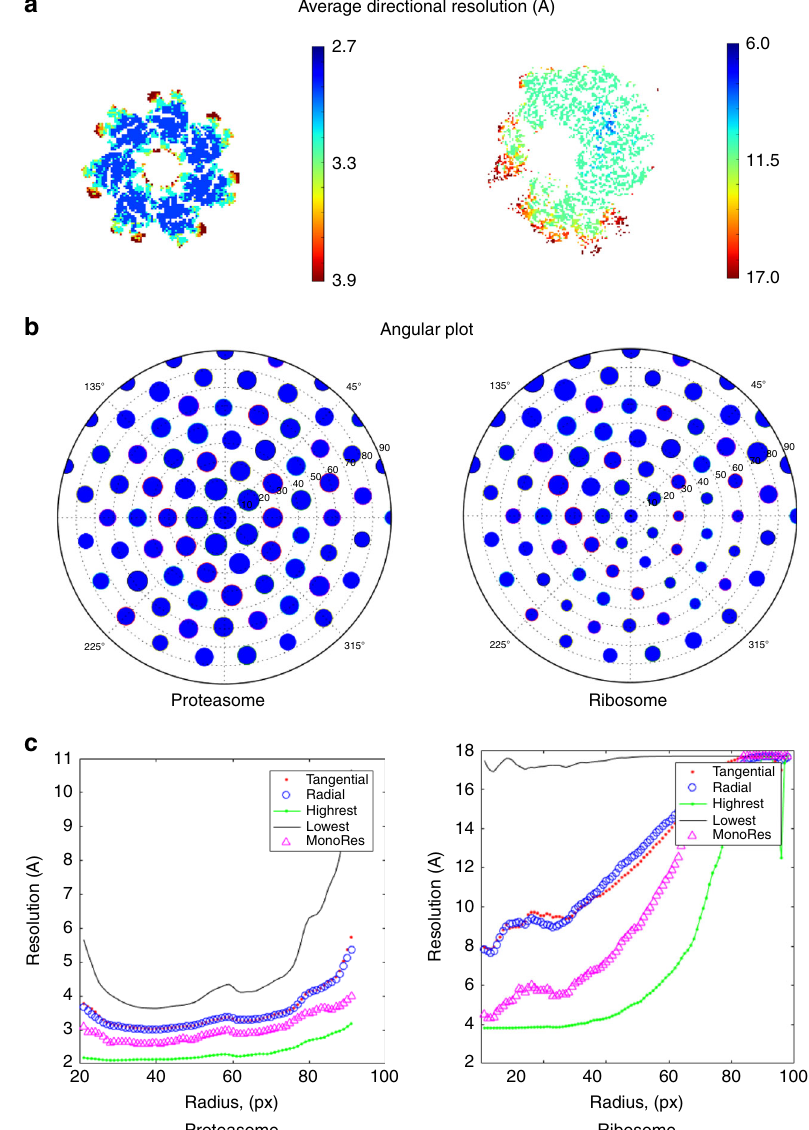
Fig. 2 Results for proteasome 20S and ribosome 80S. a Average Directional Resolution (ADR), ( b ) polar plot, and ( c ) radial average of local tangential (pink points) and radial (blue circles) directions plotted along radii, together with the highest (green points), lowest (black continuous) and MonoRes (violet triangles) local resolution